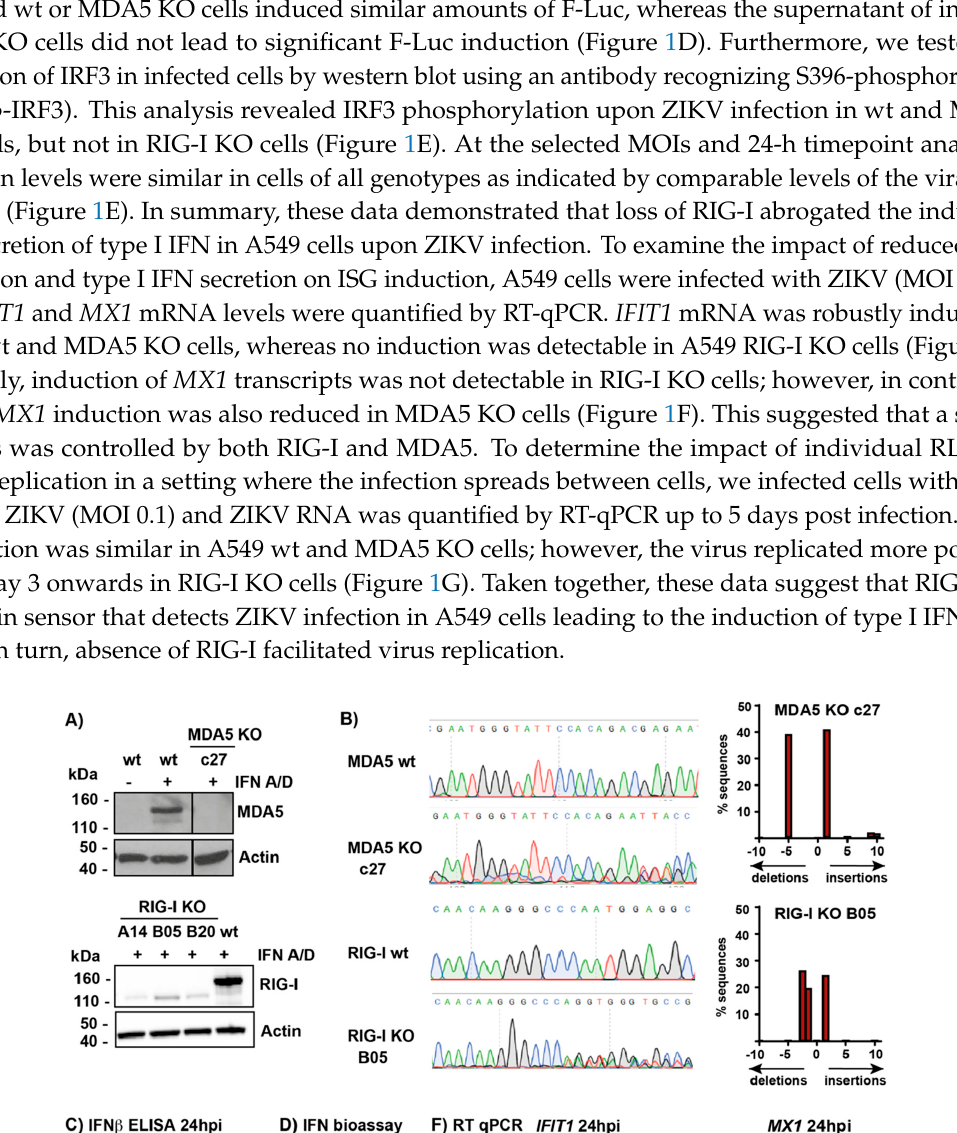
Figure 1. Retinoic acid-inducible gene I (RIG-I) is the main sensor for Zika virus (ZIKV) infection in A549 cells. ( A ) A549 cells were knocked-out for melanoma differentiation-associated gene 5 (MDA5) or RIG-I as described in Materials and Methods. Cells were stimulated with recombinant type I IFN (IFN-A/D) to induce MDA5 and RIG-I to detectable levels and lysates were analyzed by western blot using the indicated antibodies. Actin served as a loading control. The vertical line indicates a cut combining two parts of the same blot. c27, A14, B05 and B20 are individual clones. wt, wild type; ( B ) Genomic DNA was extracted from MDA5 KO clone c27 or RIG-I KO clone B05 cells. A fragment of DNA surrounding the targeted area was amplified by PCR and sequenced (left). Sequences were analyzed using TIDE (right). The number of nucleotides inserted or deleted, and the percentage of sequences affected are shown; ( C ) A549 MDA5 KO or RIG-I KO cells (clone B05) were infected with ZIKV (MOI 0.1 or 1), supernatant was collected 24 h later and IFN β levels were analyzed by ELISA. The horizontal dashed line indicates the detection limit; n.d., not detectable; ( D ) A549 cells were infected with ZIKV (MOI 1) and supernatant was collected 48 h later. HEK293 cells stably expressing Table 1. ISRE reporter were incubated with the supernatant and F-Luc activity was measured after 24 h. Shown is the fold induction relative to supernatant from mock infected cells. E ) A549 cells were